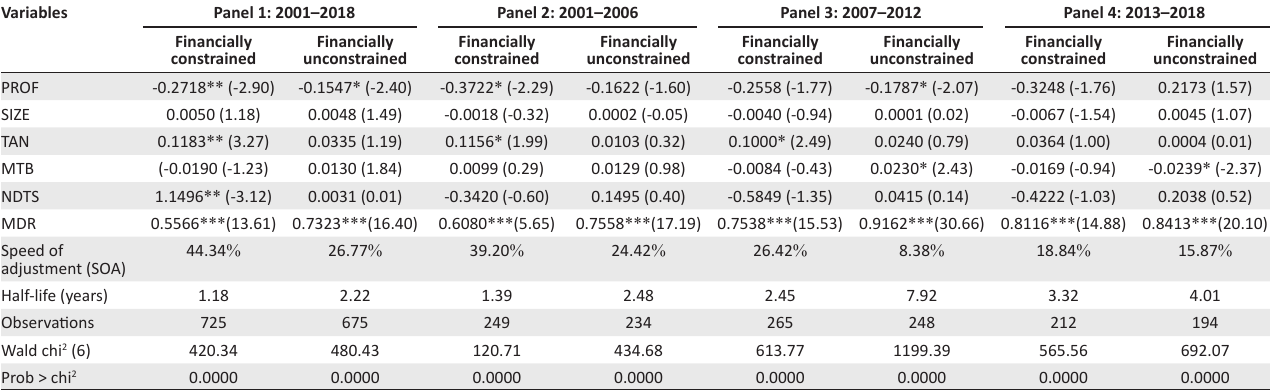
TABLE 4: All panels random-effects tobit estimator regression estimates for empirical model 2 †.